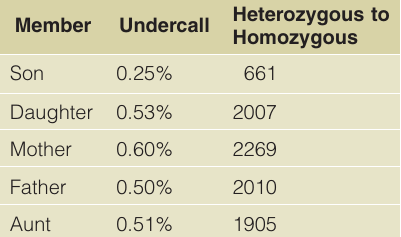
Table 2. Number of heterozygous sites mistakenly reported as homozygous